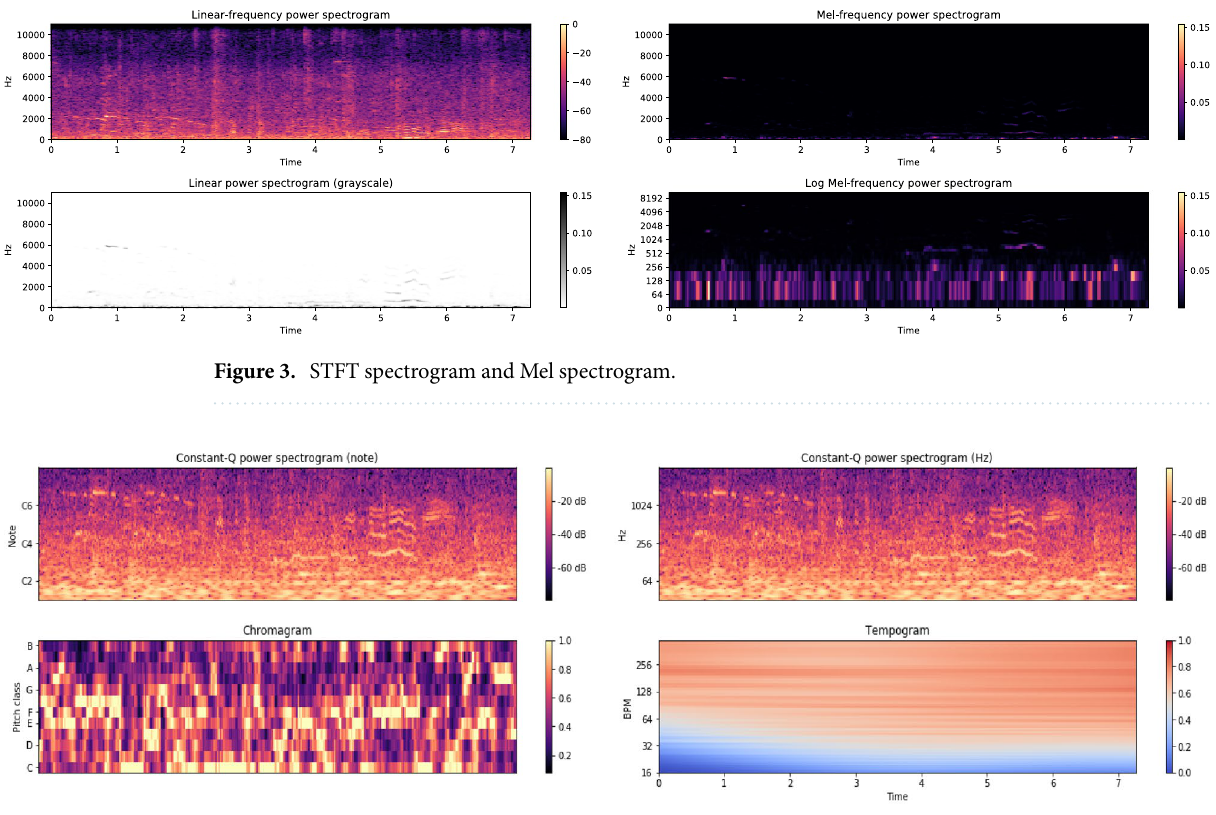
Figure 4. Chroma-CQT, chromatogram, and tempogram of an environmental sound signal,